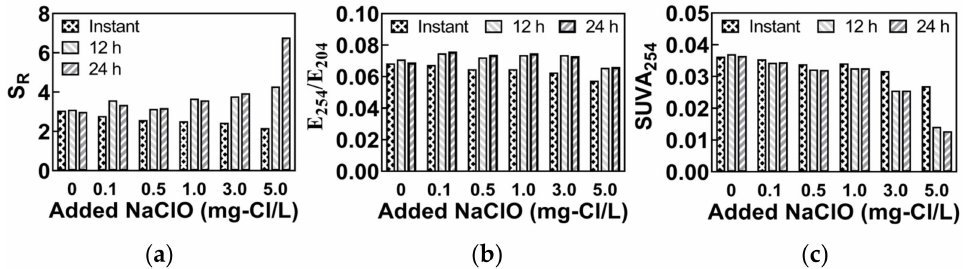
Figure 2. The characteristics of DOM under chlorine oxidation. ( a ) The change of average molecular weight of DOM (S R Value). ( b ) The hydrophobicity of DOM (E 254 /E 204 value). ( c ) The aromaticity of DOM (SUVA 254